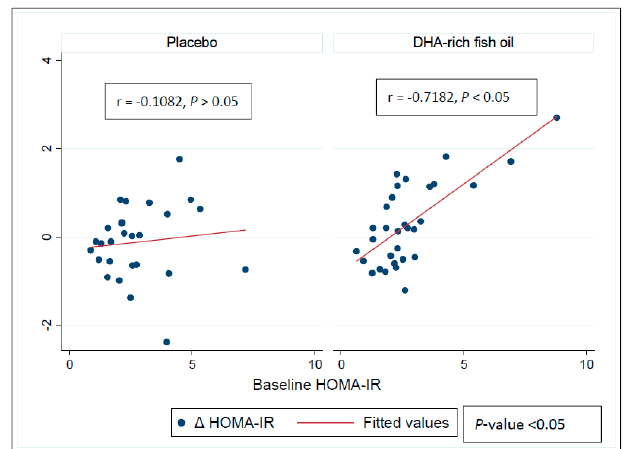
Figure 3. Pearson’s product–moment correlations exhibiting relationship between baseline HOMA-IR values and responses to intervention in the placebo and the DHA-rich fish oil groups. p -value represents differences in correlations between the groups. HOMA-IR: homeostatic model of assessment-insulin resistance.